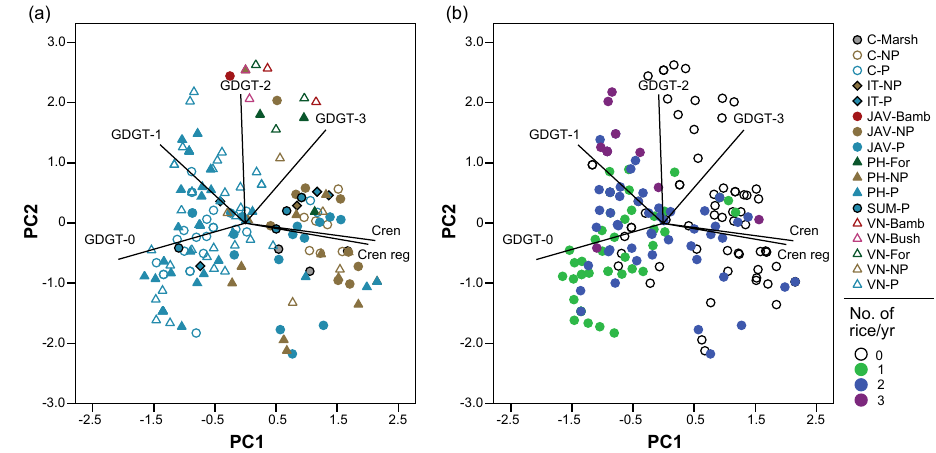
Figure 7. Principal component analysis (PCA) based on standardized relative abundances of six iGDGTs in 170 investigated soils. The first principal component (PC1) accounted for 53.9% of the total variance and the second (PC2) for 29.9%. Panel (a) : symbols and colours in upper legend denote different management forms. Abbreviations as in Fig. 2. Panel (b) : colours of the sample site symbols in lower legend are indicative of the number of rice cultivation cycles per year (“No. of riceyr − 1